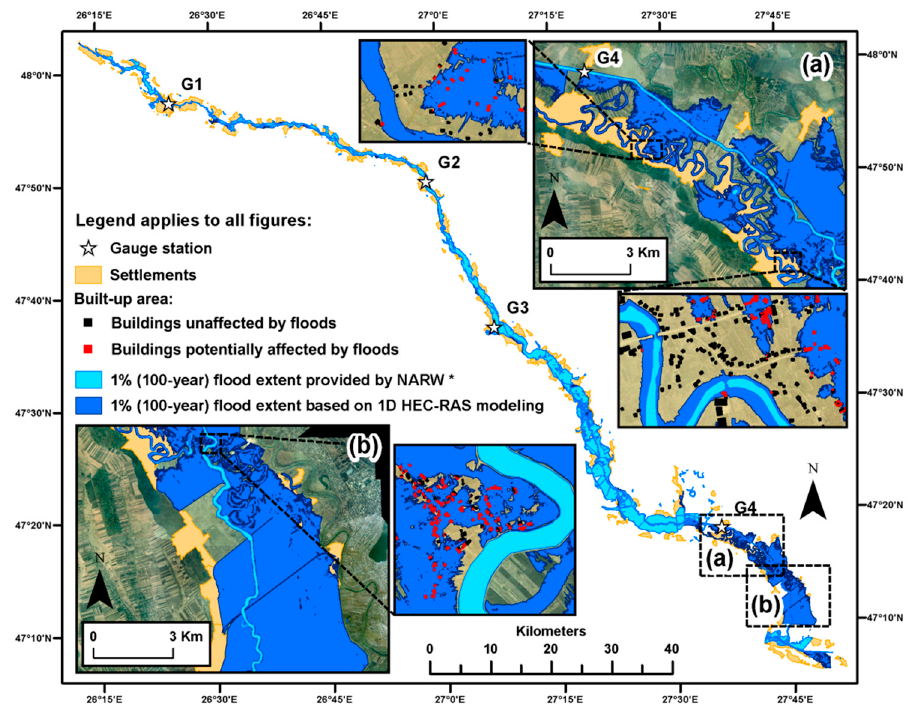
Figure 10. Comparison between official flood extent provided by NARW for 1% (100-year) recurrence interval probability and 1D HEC-RAS flood extent for 1% (100-year) recurrence interval probability. The significant differences recorded within the lower sector of the Jijia floodplain are highlighted for sections ( a , b ).